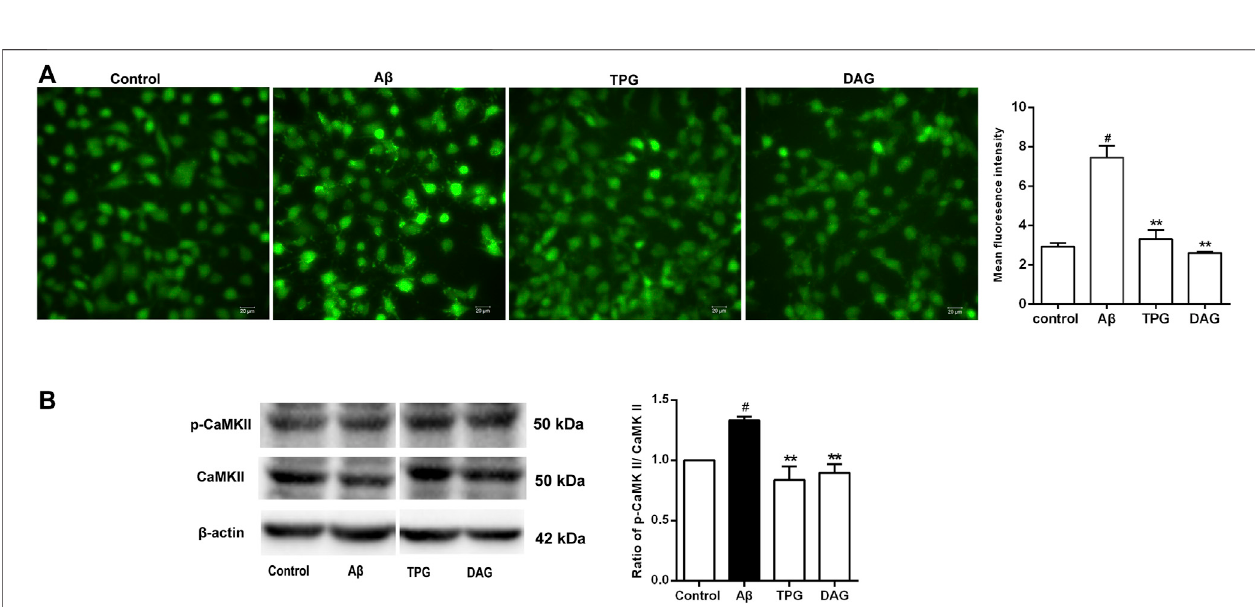
FIGURE6| TheregulationofTPGandDAGonthecalciumoverloadintheA β 25 – 35 -exposedcells (A) Theimageofintracellularcalciumindifferentgroupsrecorded by a fl uorescence microscope. Scale bars: 20 μ m (B) The expression level of CaMKII and its phosphorylation in different groups were measured by western blot. All valueswereshownasmean ± SEMfromthreeindependentstudies.Statisticalanalyseswereperformedusingone-wayANOVAandTukey-HSDposthoccomparisons. ＜ 0.01, vs. A β # p < 0.05, vs. control group; * p ＜ 0.05, vs. A β 25 – 35 models; ** p 25 – 35 models. TPG, tortoise plastron gelatin; DAG, deer antler gelatin.